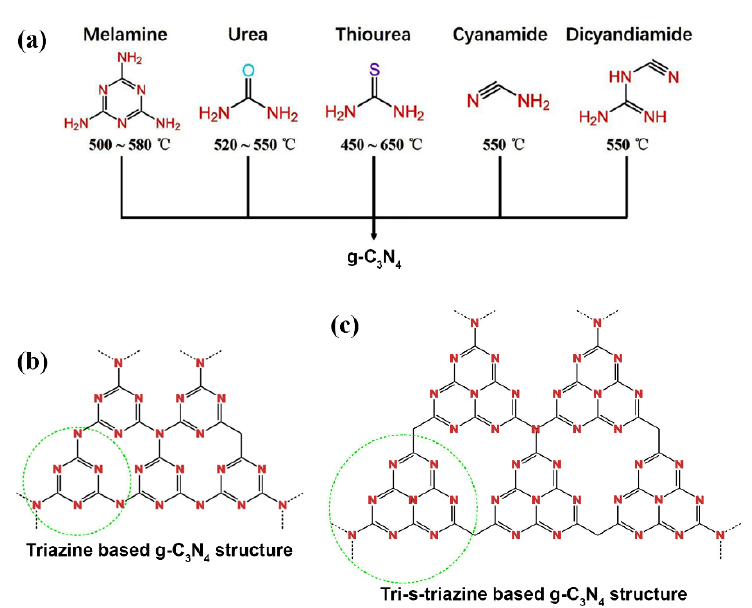
Figure 4. ( a ) Molecular structures of the g-C 3 N 4 precursors and the corresponding temperatures used for the thermal polycondensation process. Reprinted with permission from [31], Copyright 2021, Elsevier. ( b , c ) Molecular structures of triazine ( b ) and tri-s-triazine ( c ) based on potential g-C 3 N 4 allotropes. Reprinted with permission from [32], Copyright 2020, Elsevier.